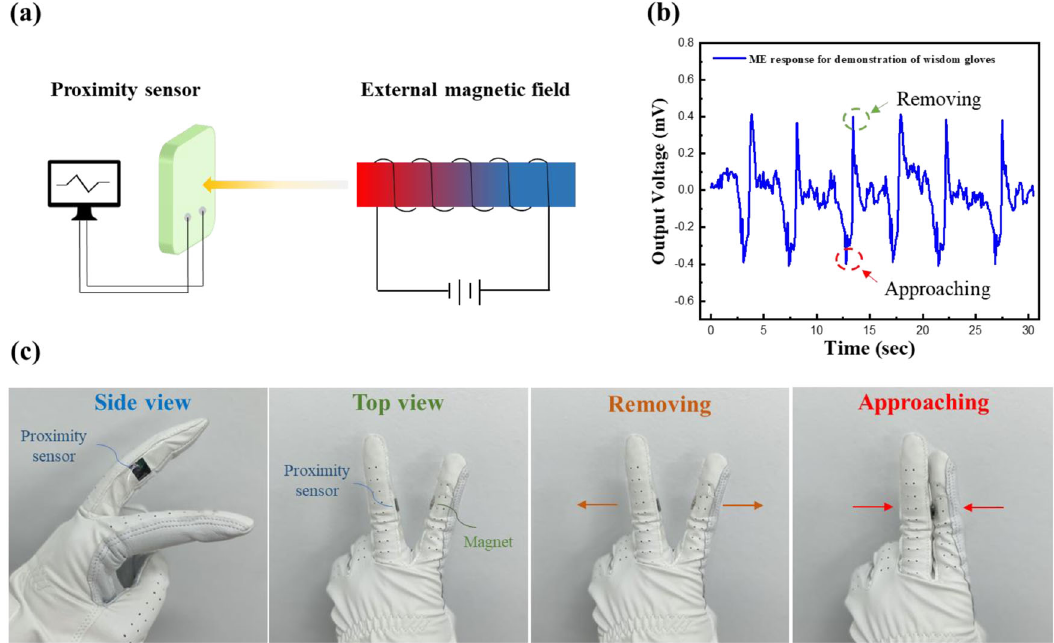
Fig. 5 Demonstration for remote motion detection via intelligent gloves. a The schematic diagram of the layout. b , c The result and corresponding fi gures for motion detection show that two fi ngers swing back and forth for about